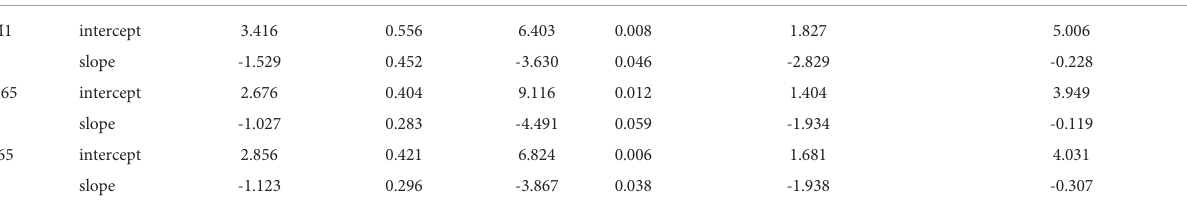
TABLE 4 Results of regression models of cross-reactive repertoires: the average values of slopes and intercepts for each